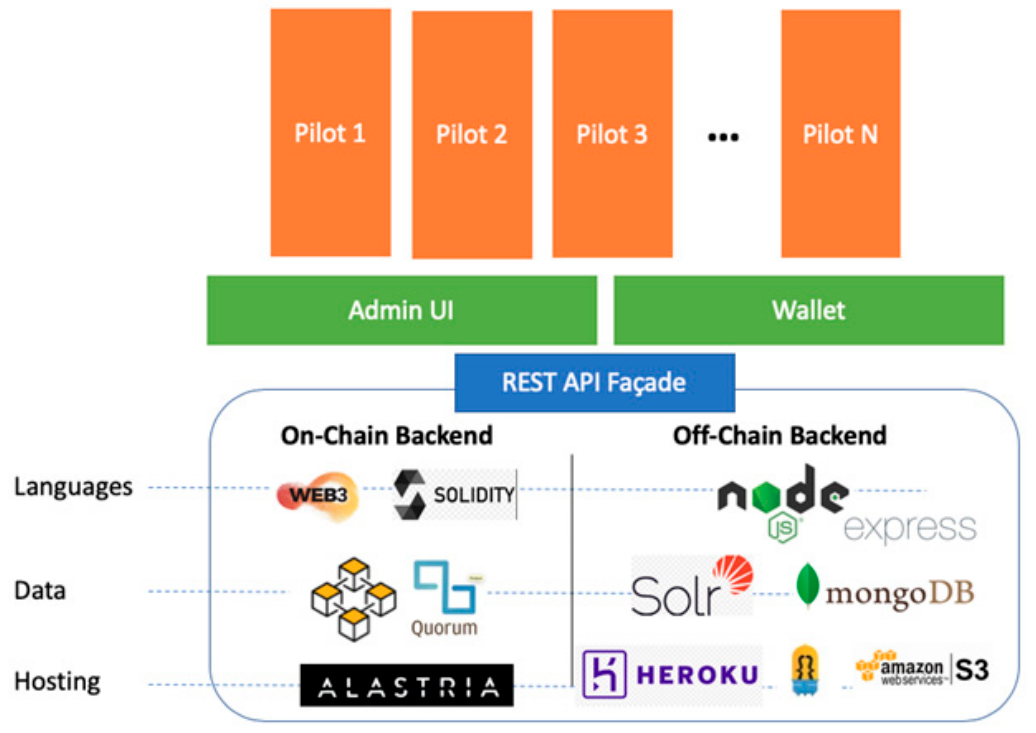
Figure 6. Technology stack from bloomen API view.